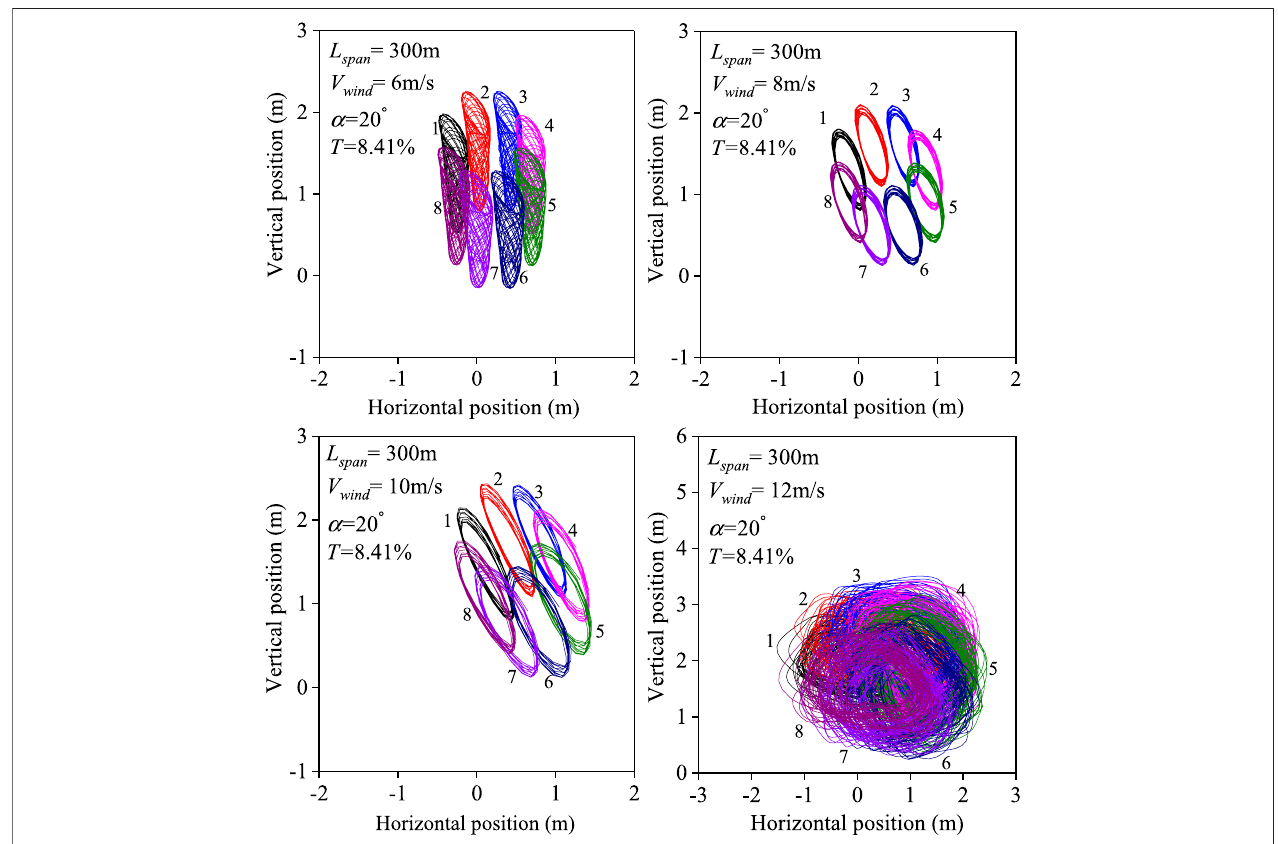
FIGURE 6 | Galloping traces of the midpoint of eight-bundle conductors under different wind velocities.